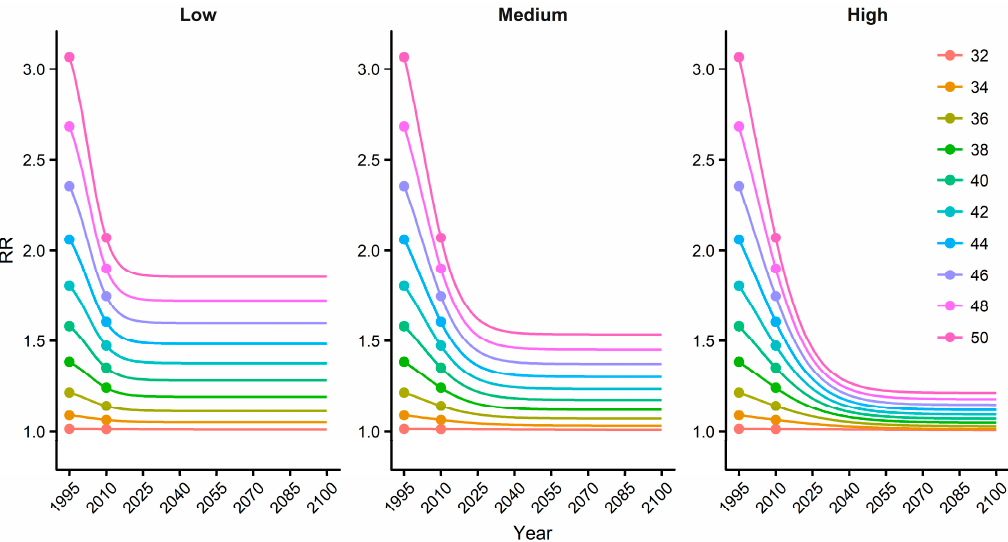
Figure 5 . Temperature-specific adaptation curves during 1995–2100. The points in 1995 and 2010 represent the relative risks (RR) for each temperature during the periods 1991–2000 and 2006–2015, respectively.